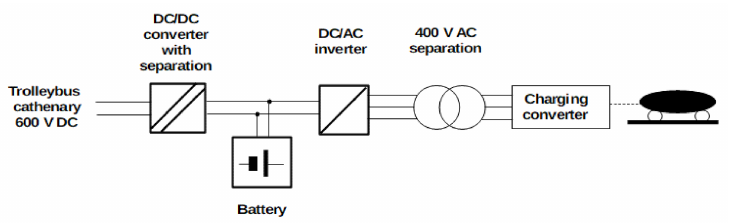
Figure 6. General connection scheme of the charging station and the trolleybus power supply line in Gdynia,